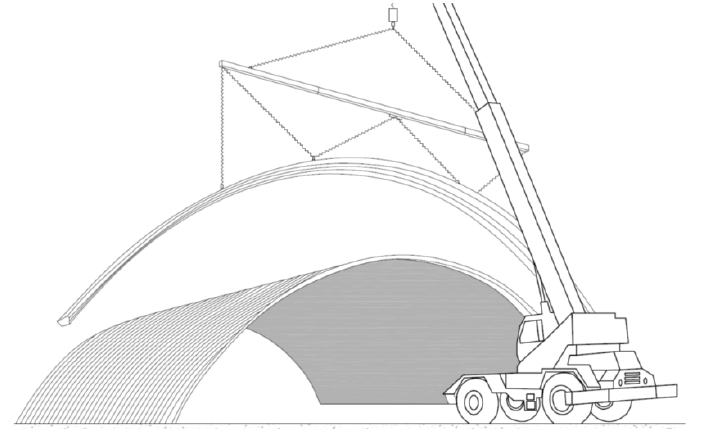
Figure 2. Assembly of an arch-shaped roof’s section.